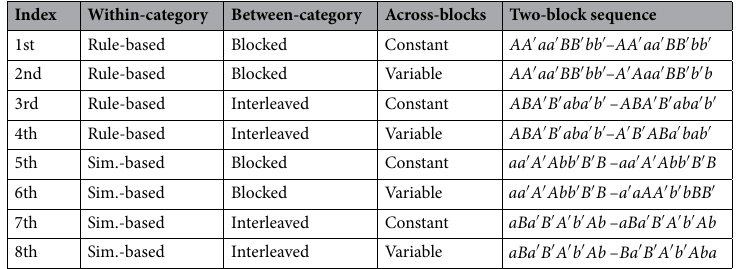
Table 1. Combination of the three manipulations (within-category, between-category, and across-blocks) that generates the eight conditions of the experiment. The last column offers an example of a two-block sequence for each condition. Stimuli can belong to either Category A (letters a , a ′ B , and B ). These categories were chosen for this table as simple as possible to exemplify different types of order more easily. Note that this category structure is not the one used in our experiment. Stimuli associated with the main rule are in capital letters, while the exceptions are in small